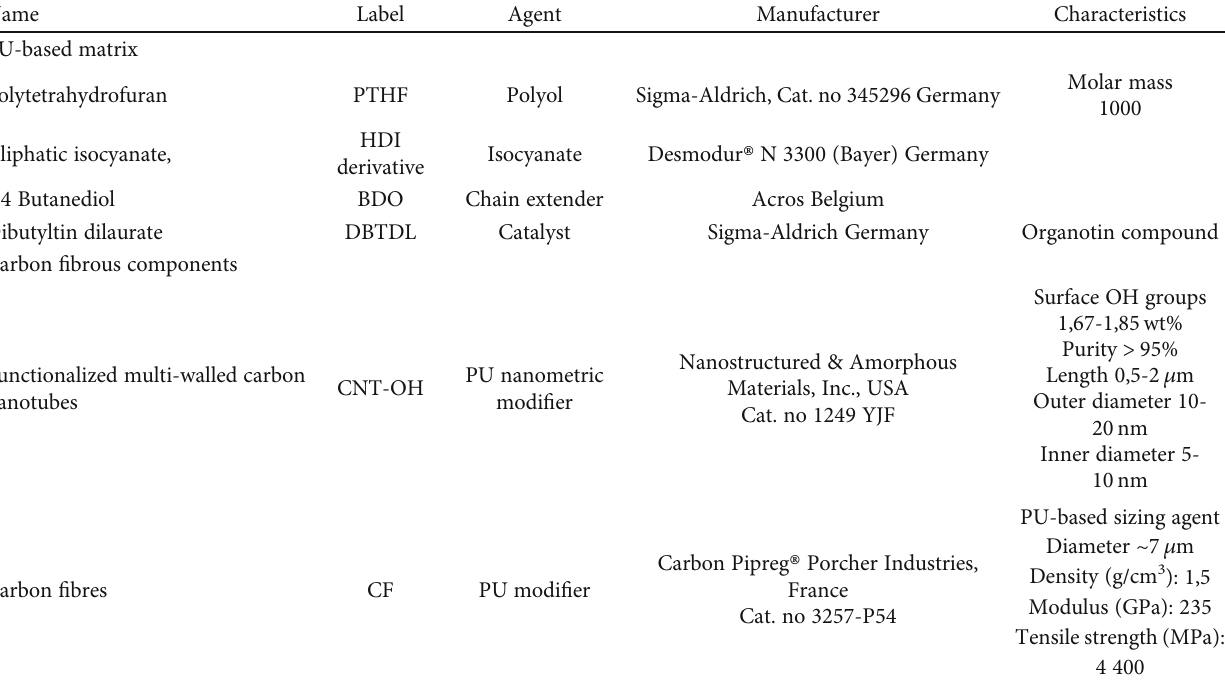
Table 1: Materials used for the preparation of PU-based nanocomposite